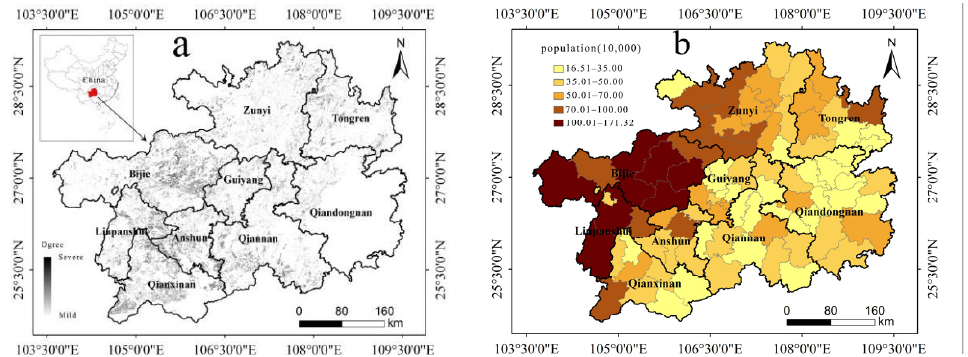
Figure 1. Degree of stone desertification in 2020 ( a ); Population distribution on the county level in 2020 ( b ).